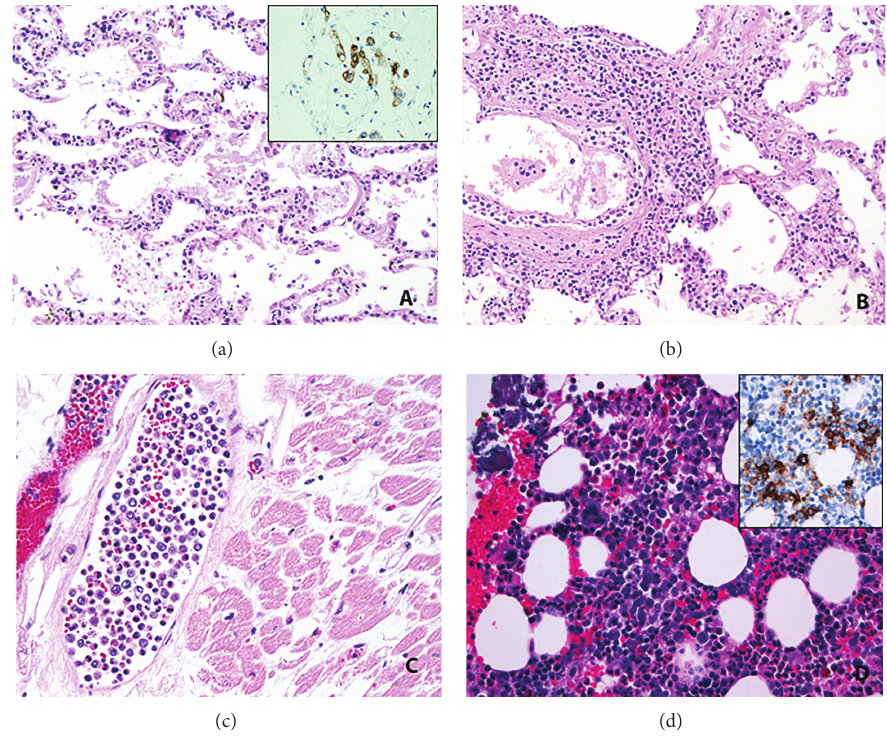
Figure 2: At autopsy, many of the organs showed involvement by intravascular diffuse large B-cell lymphoma. The alveolar wall showed large atypical cells in the capillaries (a) that were positive for CD20 (inset). Within the arteriole wall of the lung were these atypical cells as well (b). The myocardium also showed these large atypical cells in the vessel lumen (c). Retrospective evaluation of the bone marrow also showed inconspicuous large cells in clusters (d) highlighted with CD20